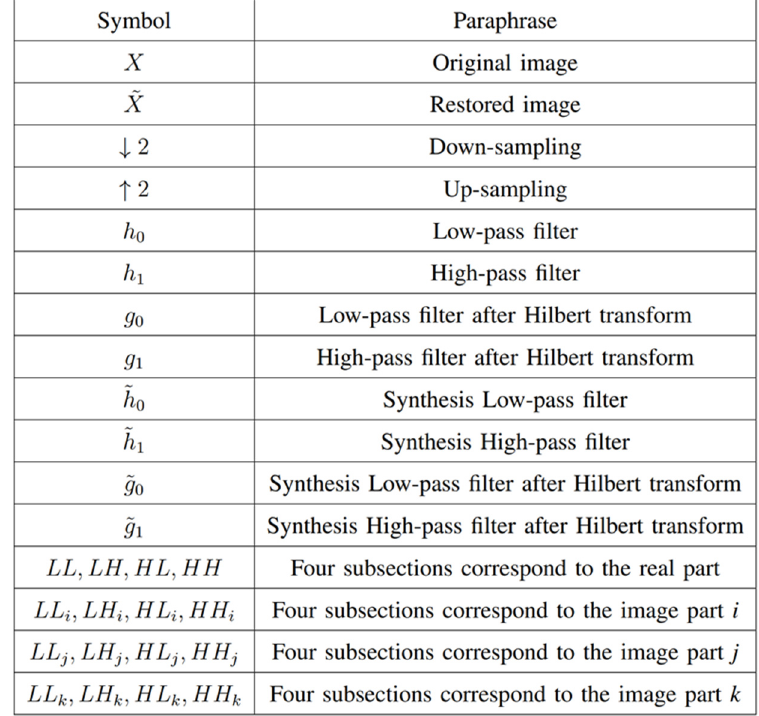
Figure 2. Flow chart of QWT algorithm.